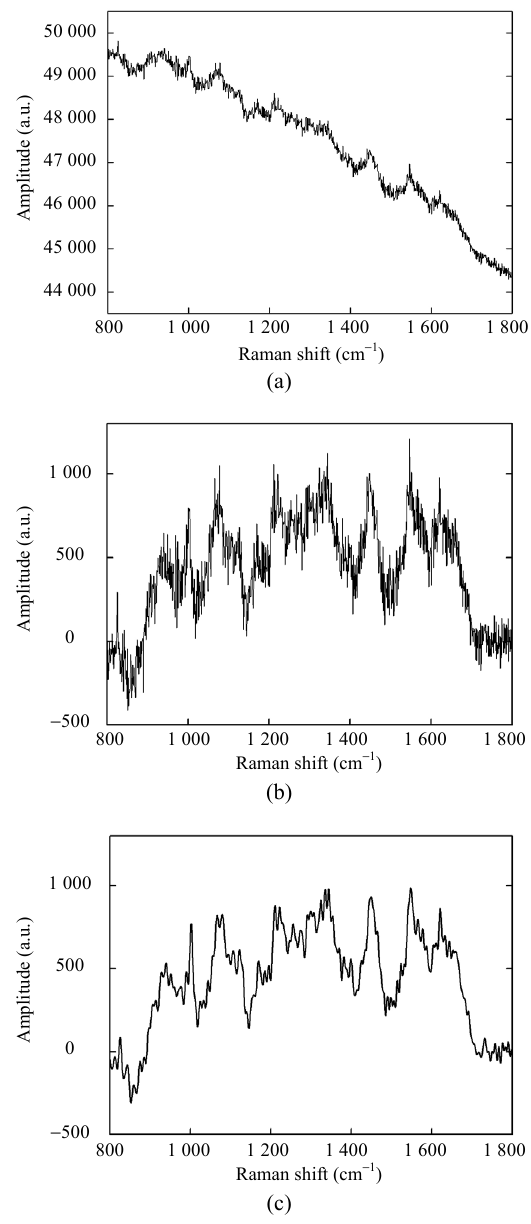
Fig. 3 Data processing: (a) the original Raman spectrum of tissue in the range of 800 cm ‒ 1 ‒ 1800 cm ‒ 1 , (b) the baseline removal Raman spectrum, and (c) the last Raman spectrum after